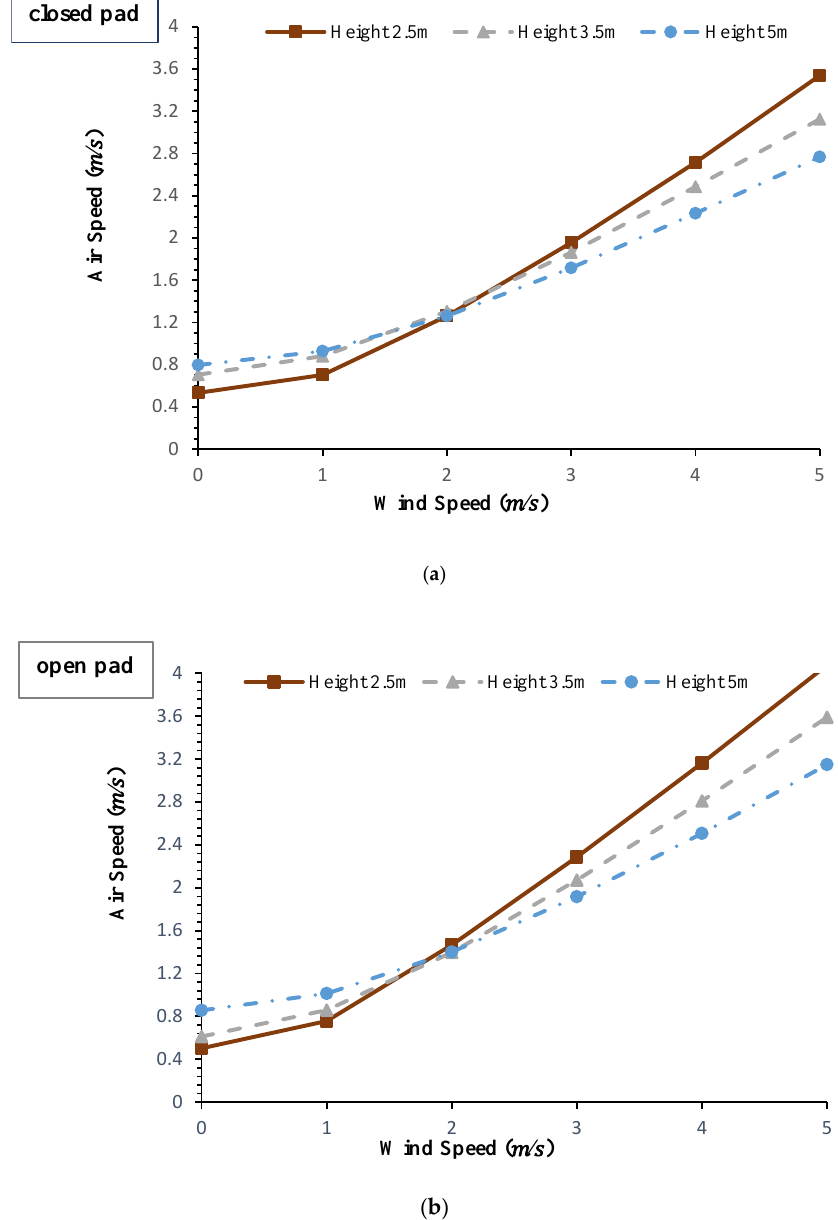
Figure 5. Effect of wind speed and wind catcher height on air speed under the conditions of Qaen city at 12:00 p.m. on 3 May 2017 and the modes of: ( a ) closed pad, ( b ) open pad.